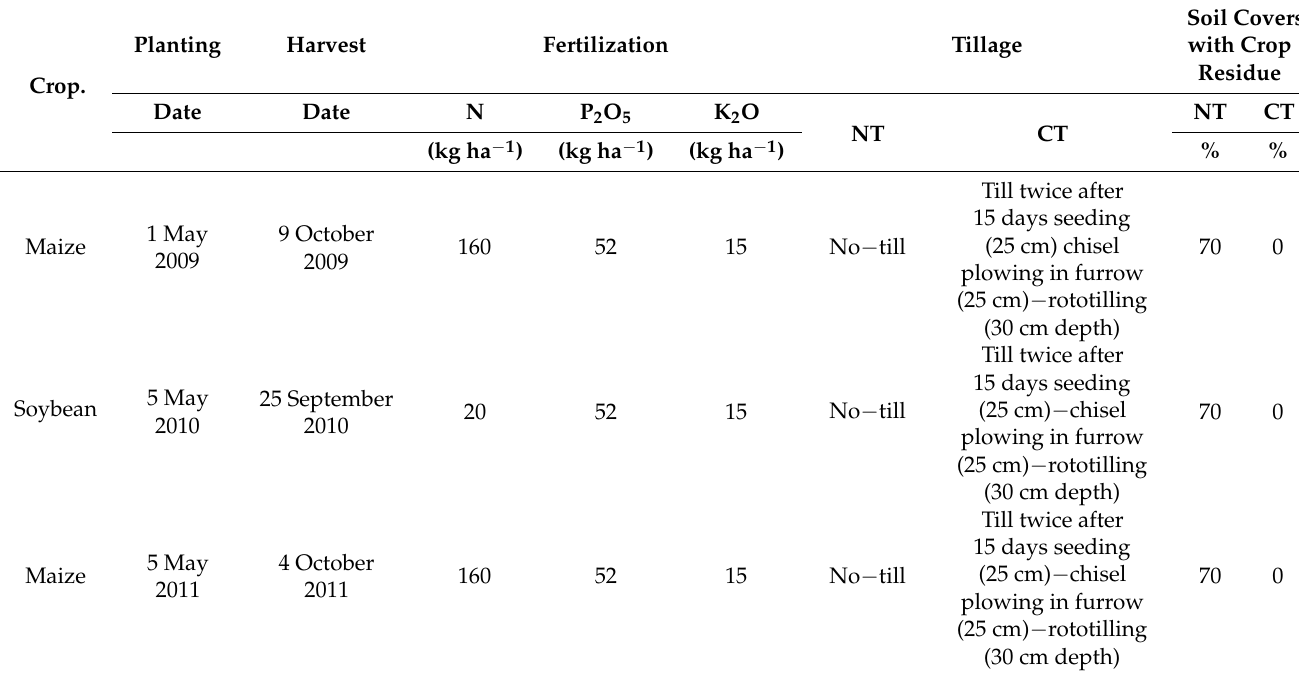
Table 2. Field management at the study